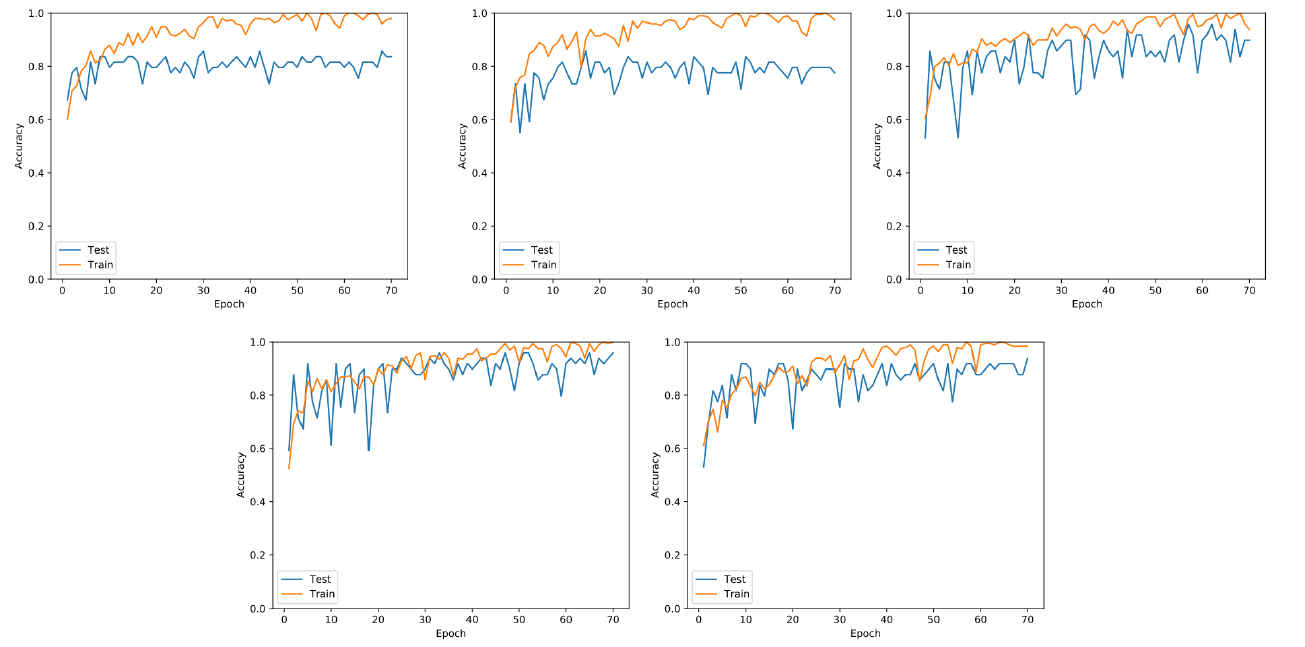
Figure 6. Learning curves for training and testing using the SqueezeNet architectecture. Although it is considered a light weight architecture, SqueezeNet achieved the second best results. Each plot corresponds to a five-fold